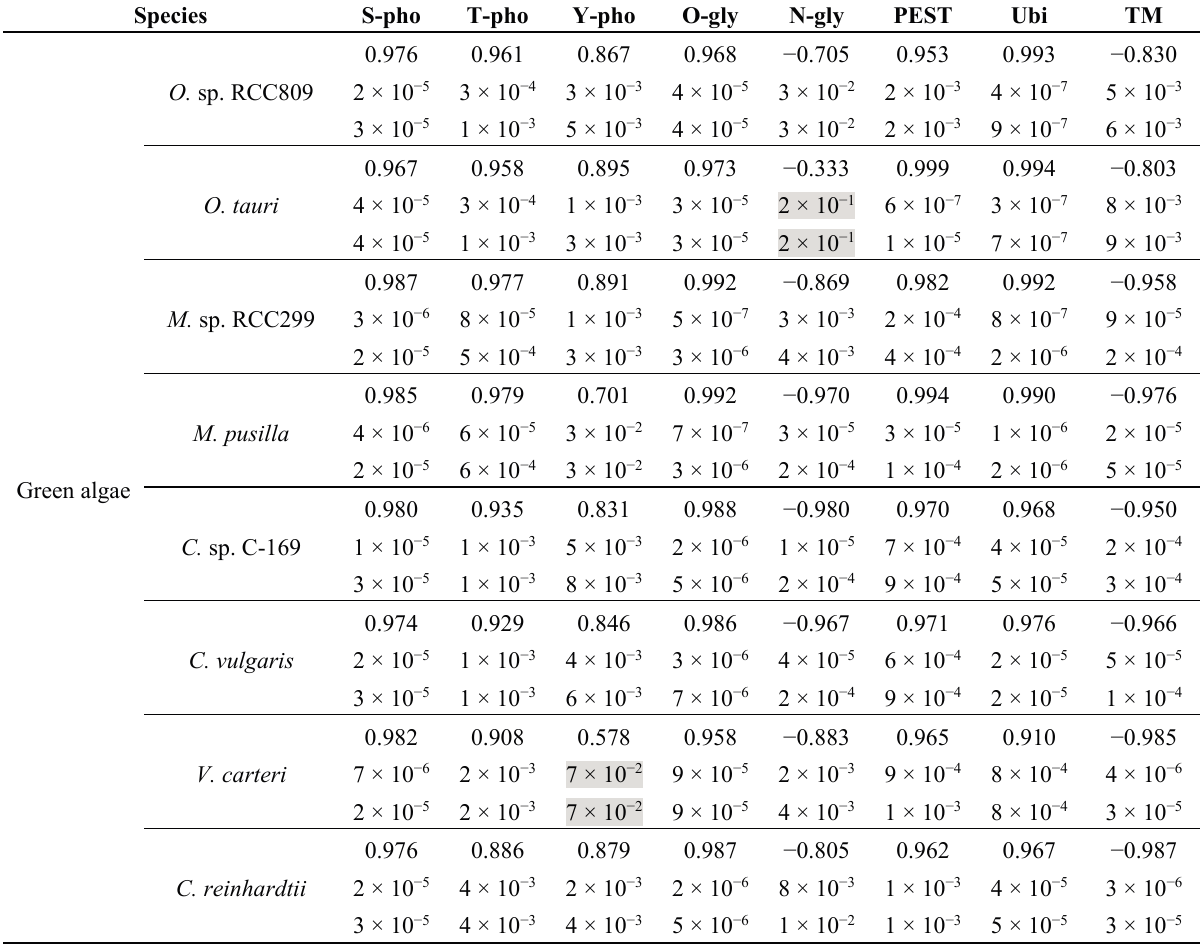
Figure 2. Correlations between disordered protein content and the number of phosphorylation sites. ( A ) Normalized predicted Ser (S), Thr (T) and Tyr (Y) phosphorylation sites per 400 amino acids in the studied algae proteomes; The relative percentage of disordered protein content with different numbers of predicted S, T and Y phosphorylation sites are presented in ( B – D ), respectively. Table 1. Statistics of the correlation between protein disorder and proteomic parameters.